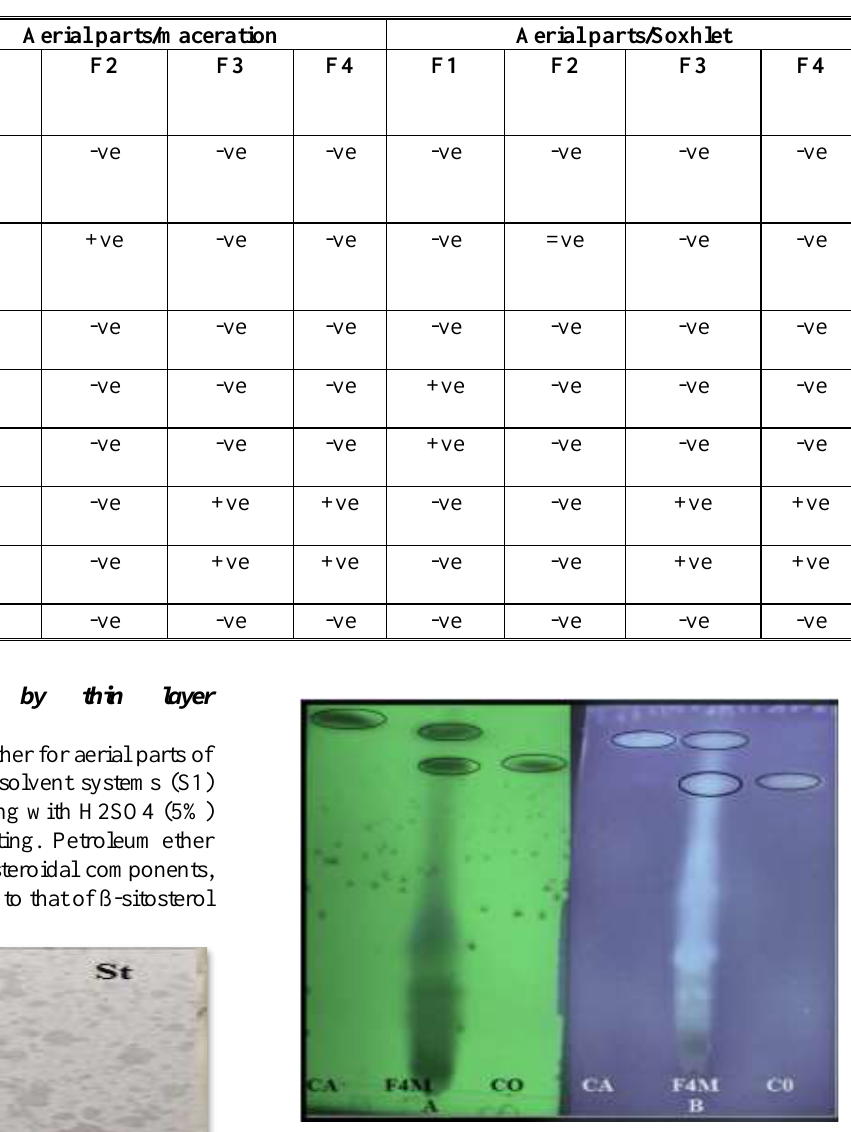
Figure 4. TLC chromatogram obtained by S2 for analyzed fractions (n-but) with caffeic acid and p-coumaric acid standards under UV light, A:254 nm and B: 366 nm